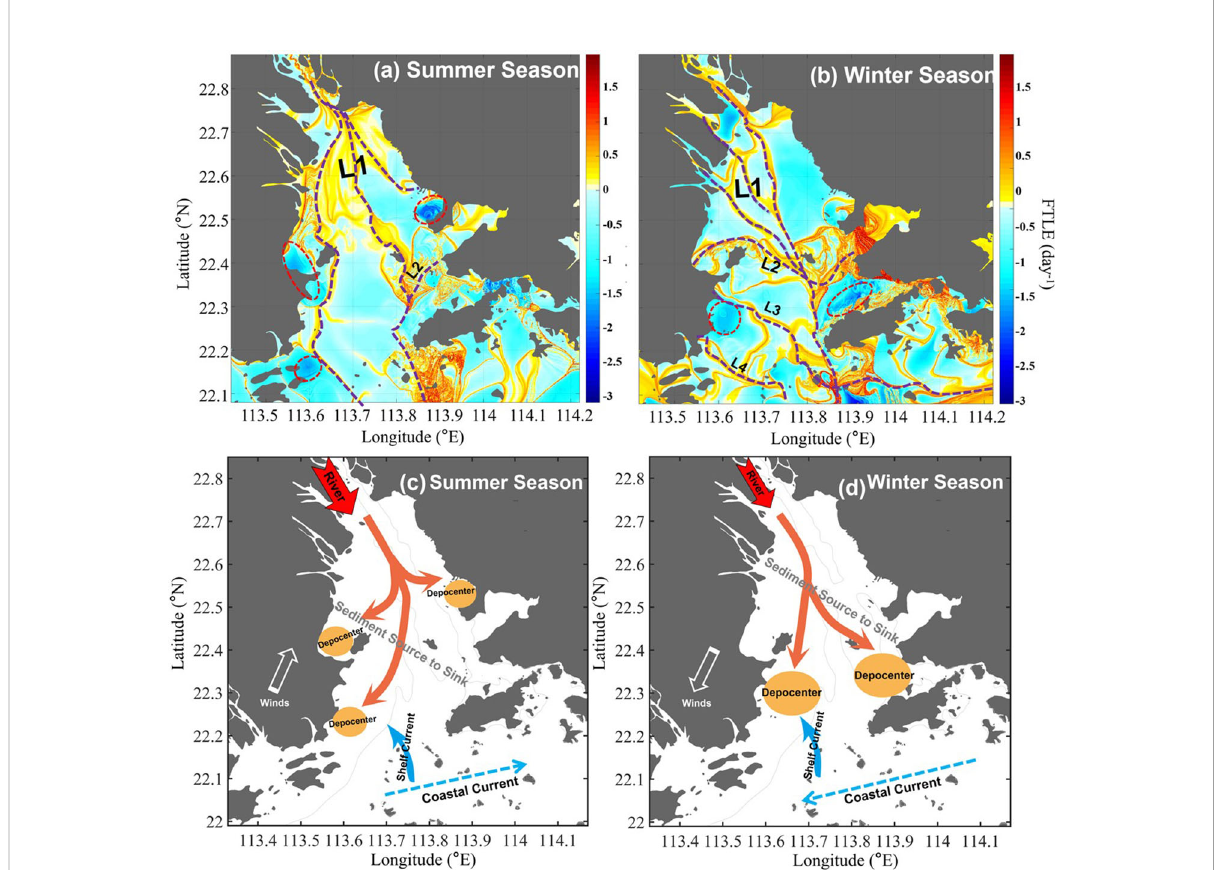
FIGURE 7 (A, B) Bottom FTLE structure in summer and winter, the dashed lines denote the main transport paths. (C, D) Schematic maps of the core transportation path of surface sediment and depocenters in the PRE in summer and winter; the gray lines are 5 m isobaths. The conceptual patterns of sediment source to sink are summarized from Zhang et al. (2019); Chen et al. (2020), and Chu et al.